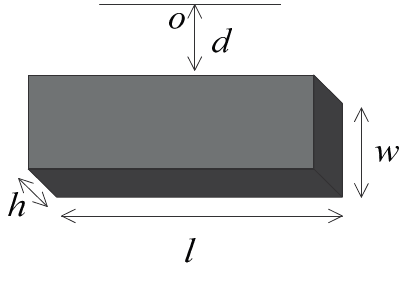
Figure 3. Dimension of the permanent